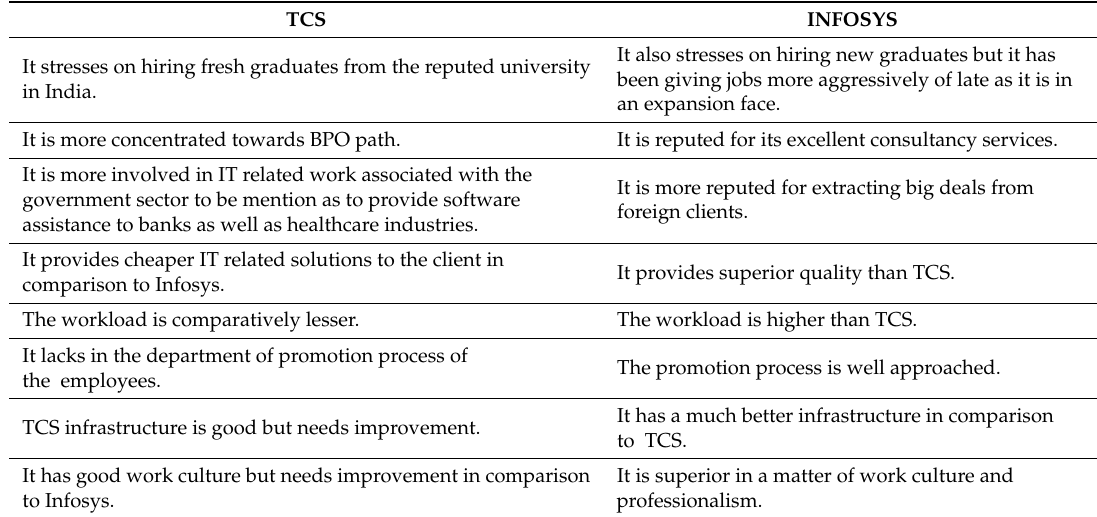
Table 2. Organization